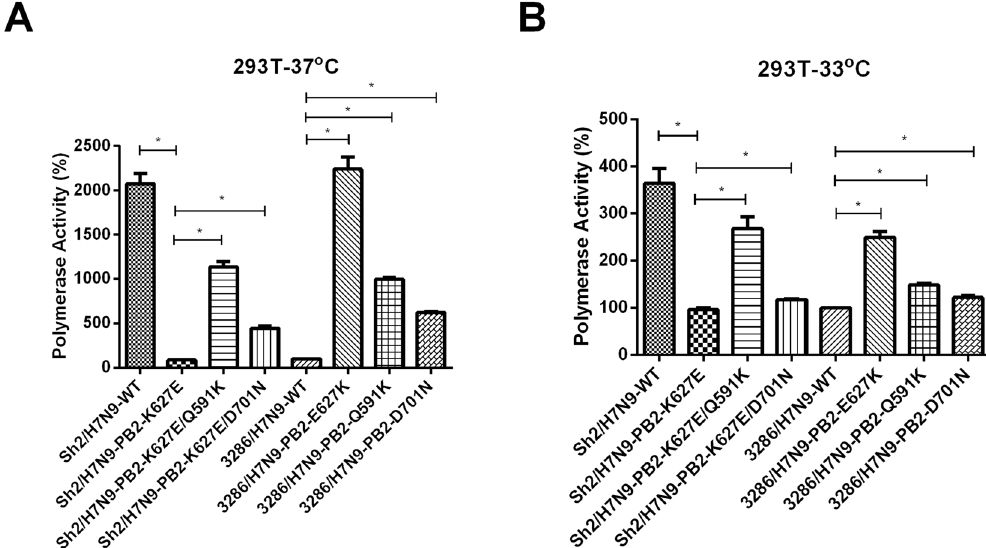
Figure 1. Polymerase activity of the H7N9 and the PB2 mutants. 293 T cells were transfected with plasmids containing PB2, PB1, PA, NP genes of either duck 3286/H7N9 or zoonotic Sh2/H7N9 plus a control luciferase reporter plasmid and a viral UTR-driven luciferase reporter plasmid. After transfection, the 293 T cells were cultured at ( A ) 37 °C and ( B ) 33 °C for 24 hour. Luciferase activity was then assayed from the cell extracts. Results are the average of three independent experiments. The values were statistical analyzed by two tailed, non-paired t-test. * p <